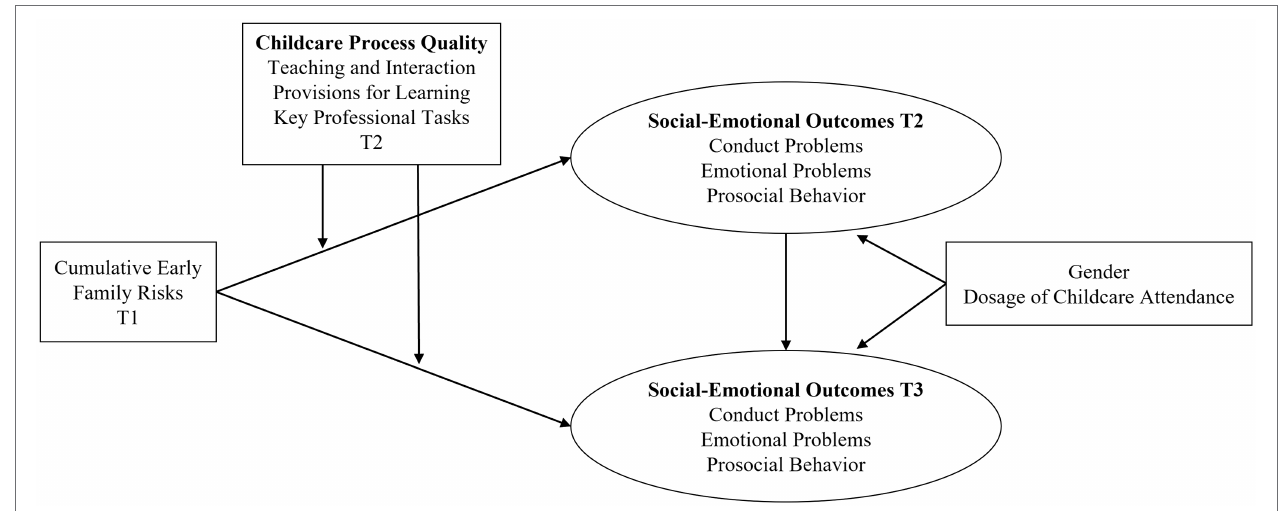
FIGURE 1 | Basic model of the study. Socio-emotional outcomes were calculated using a multi-informant approach (parent and teacher ratings), controlling for gender as well as intensity and duration of childcare attendance. T1, T2, and T3 = waves of